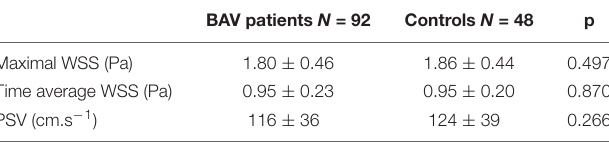
FIGURE 5 | Correlations of the following stiffness indicators ( Y -axis) with age ( X -axis): Distensibility (A) and MRSD (B) , for patients with bicuspid aortic valve (BAV) (red) and controls (blue). BAV, bicuspid aortic valve; MRSD, maximal rate of systolic distension. TABLE 3 | Flow parameters of BAV patients and